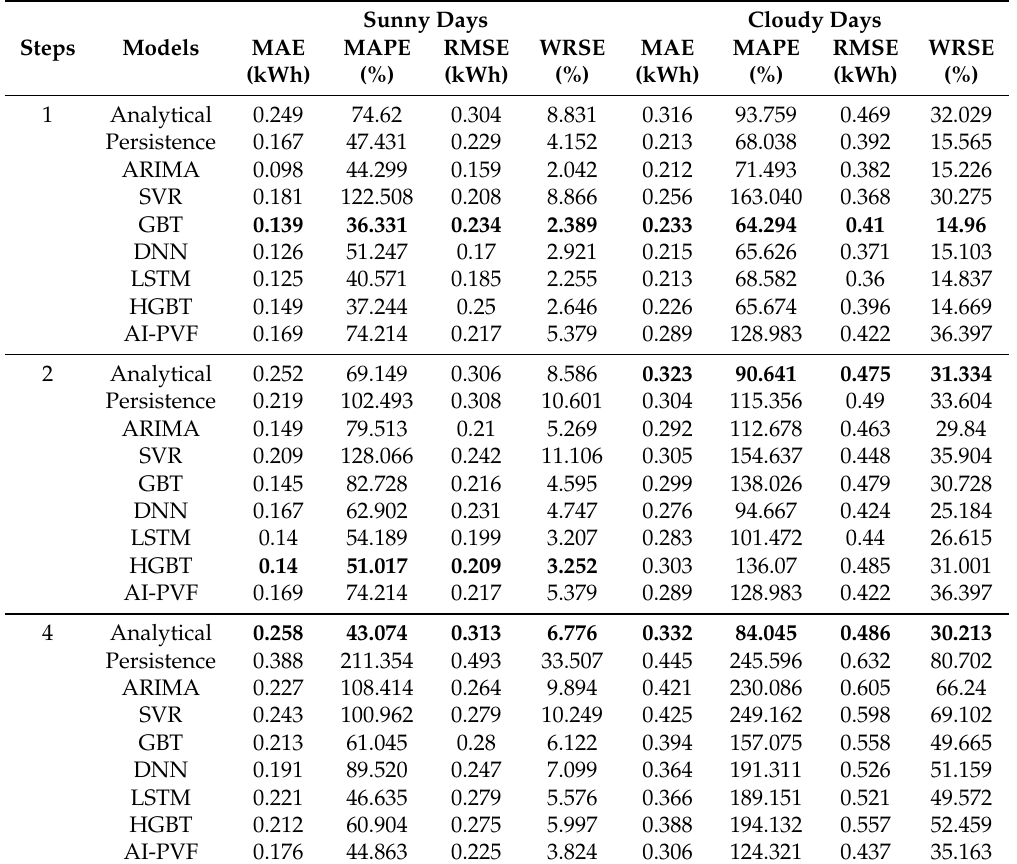
Table 6. Forecasting accuracy results for the winter